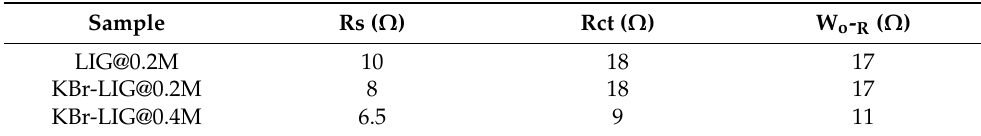
Table 3. The value of solution resistance (Rs), electron transfer resistance (Rct), and Warburg resistance for the tested